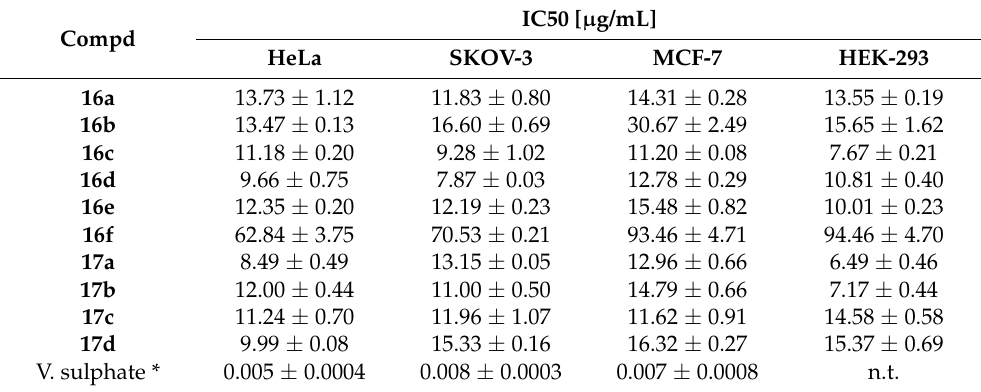
Table 4. The IC50 [ µ g/mL] for compounds 16a–16f and 17a–17d on cancer and noncancerous cell